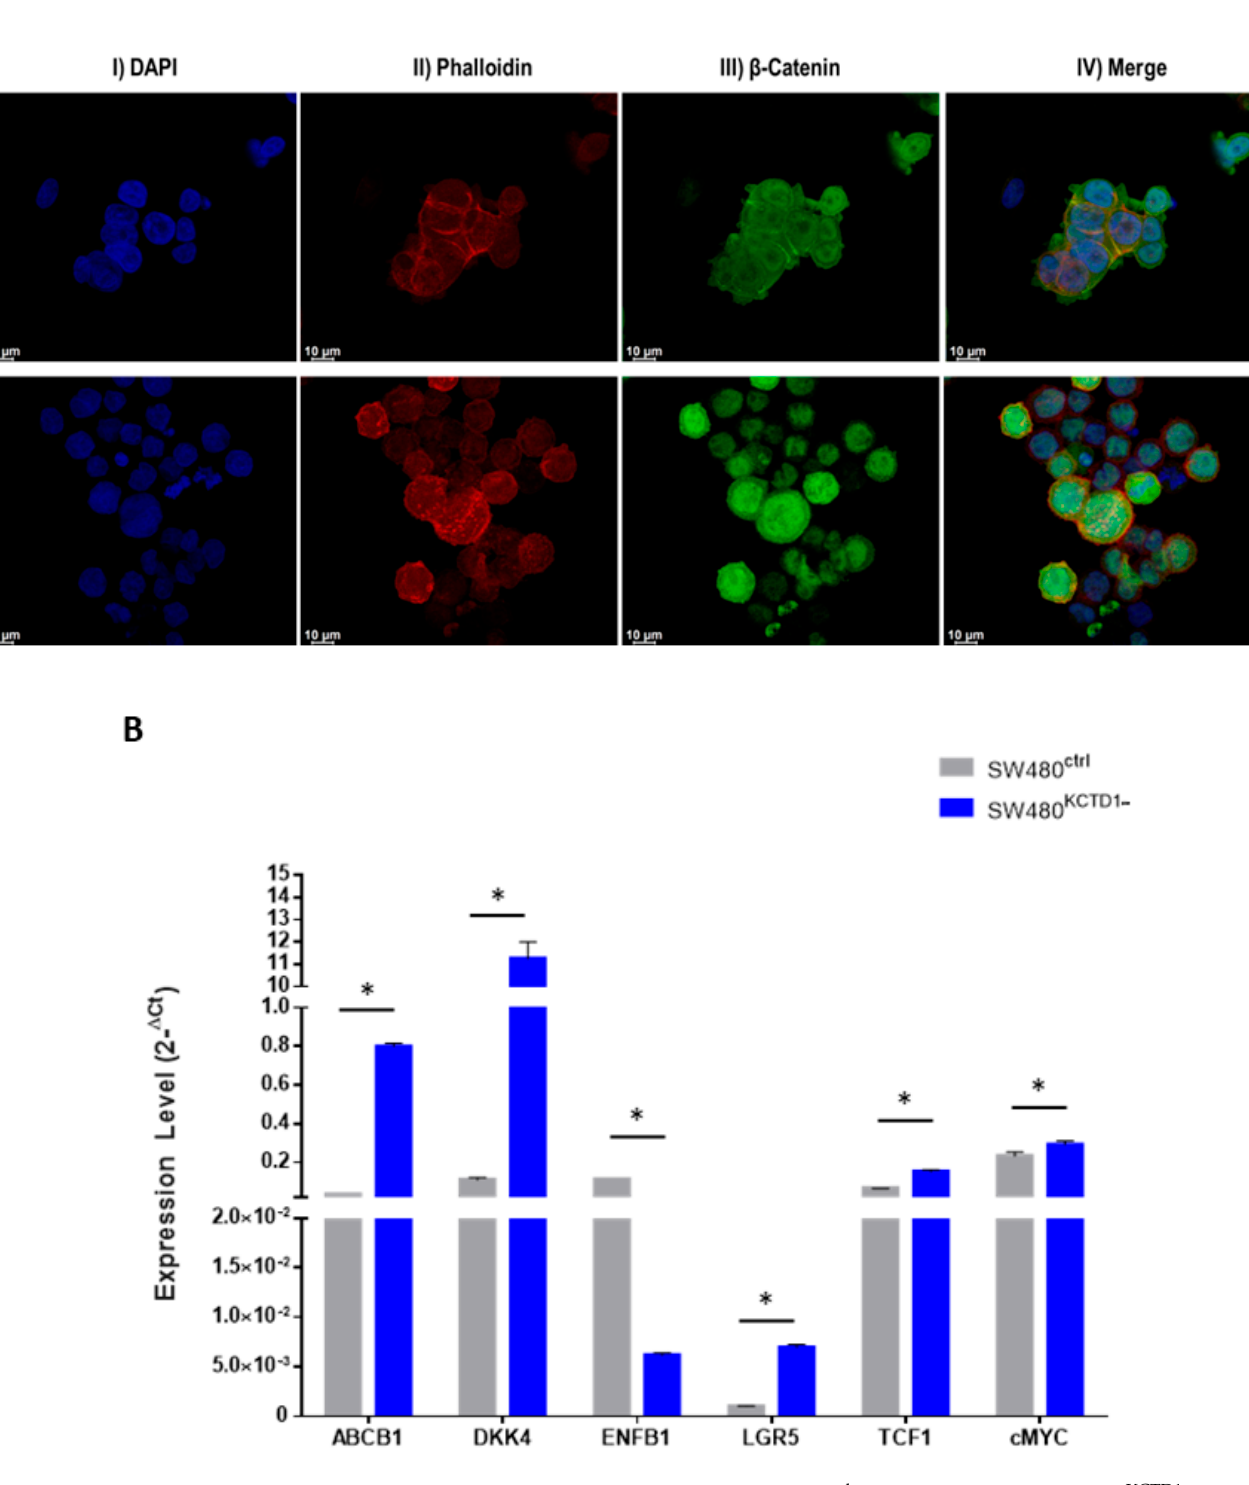
Figure 6. ( A ) Immunofluorescence analysis of SW480 ctrl (upper panels) and SW480 KCTD1 − (lower panels). (I) Nucleus staining with DAPI (blue), and (II) Phalloidin-Dye light 554. (III) β -catenin staining with Alexa588-conjugated secondary antibody. (IV) Merging of DAPI, Dye light 554, and Alexa 488. Magnification 63 × . Scale bars 10 µ m. ( B ) mRNA expression levels of β -catenin targets in SW480 ctrl (grey bars) and SW480 KCTD1 − (blue bars) cells after 72 h of active growth. Relative expression was determined using the 2 − ∆ Ct method. Relative expressions of β -catenin target genes are shown as mean +/ − SD of three technical independent experiments. * = p < 0.05, Mann–Whitney t